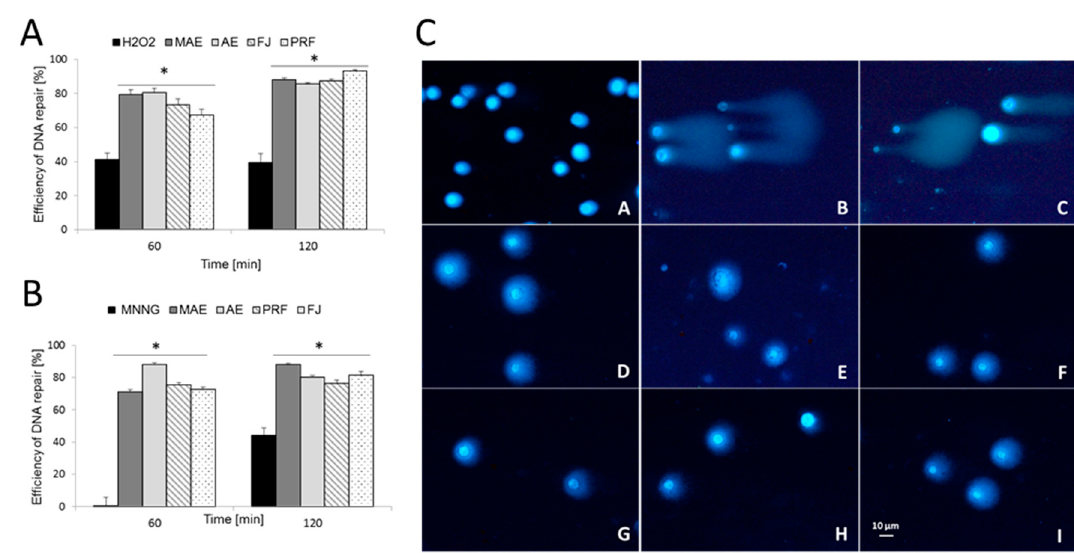
Figure 5. The V. opulus extracts’ (FJ—fresh juice, PRF—phenolic rich fraction, MAE—methanol-acetone extract, AE—acetone extract) activity as protectants against DNA damage. Efficiency of DNA repair (%) in Caco-2 cells exposed for 10 min to mutagens: ( A ) hydrogen peroxide (25 μ M) and ( B ) MNNG (6.8 μ M) on ice. The cells were then post-incubated (at 37 °C for 60 and 120 min) with extracts and DNA repair was measured in the time intervals. The number of cells analyzed for each time-interval was 50. Error bars denote S.E.M. ANOVA ( p ≤ 0.05). * Significantly different from the positive control. Typical images of Caco-2 comets stained with DAPI: ( A ) negative control; ( B ) hydrogen peroxide (25 μ M); ( C ) MNNG (6.8 μ M). After pre-incubation with hydrogen peroxide, 120 min post-treatment with extracts: ( D ) MAE extract; ( E ) AE extract and ( F ) PRF extract. After pre-incubation with MNNG, 120 min post-treatment with extracts: ( G ) MAE extract; ( H ) AE extract and ( I ) FJ extract. Fluorescence microscopy (Nikon, Tokyo, Japan); 200× magnification ( C ).